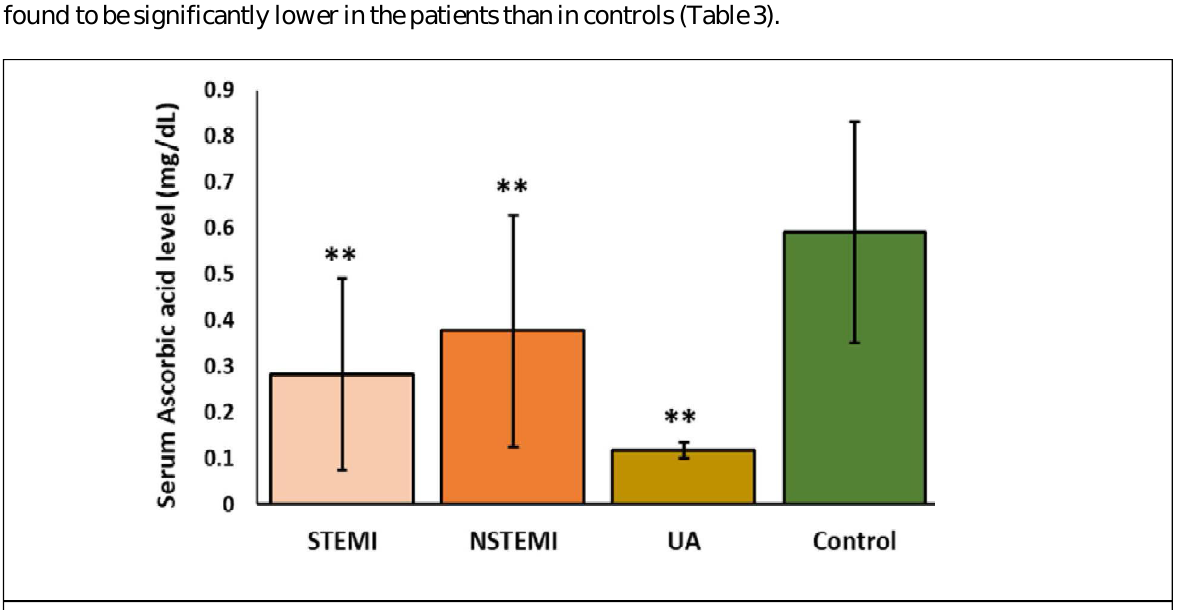
Figure 2: Comparison of the levels of serum ascorbic acid in various ischemic subgroups of ACS patients and controls. The results showed that all three subgroups of patients [with ST-Elevation Myocardial Infarction (STEMI), Non-ST Elevation Myocardial Infarction (NSTEMI) and Unstable Angina (UA)] had significantly lower values than controls; and ** p <